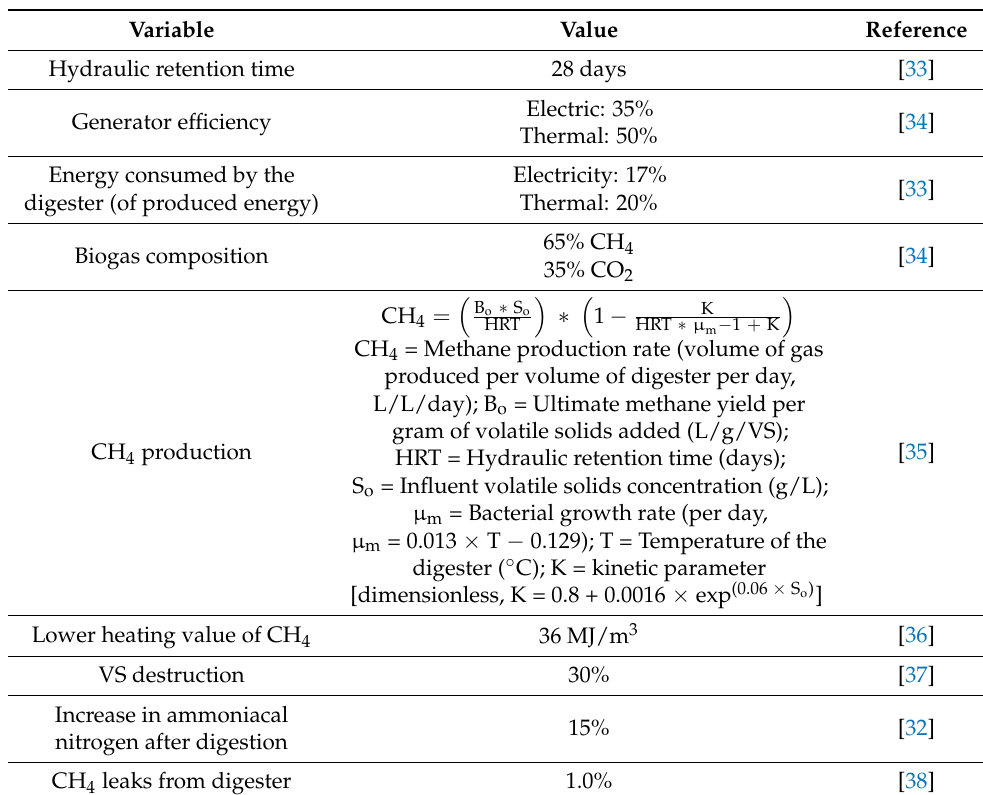
Table 2. Variables considered to estimate energy production from anaerobic